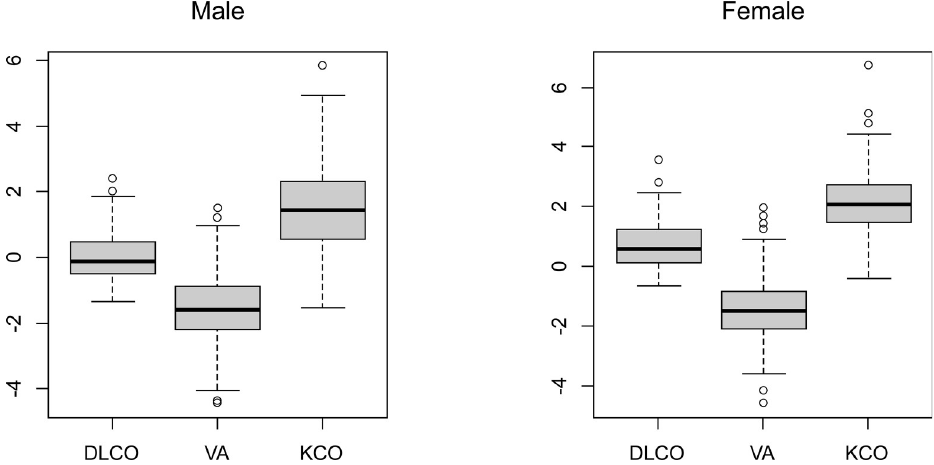
Fig 1. Box plots of the D LCO , K CO (D LCO /V A ), and V A z-scores adjusted for the age and height, based on the Global Lung Function Initiative 2017 equations in 390 Japanese patients (193 men and 197